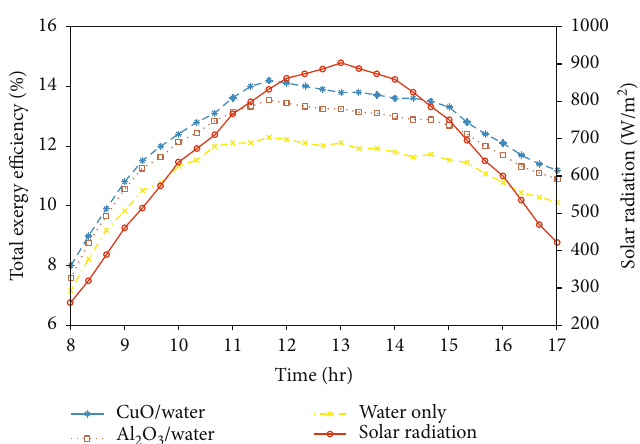
Figure 10: Daily variations of total exergy e ffi ciency with solar radiation (CuO/water and Al